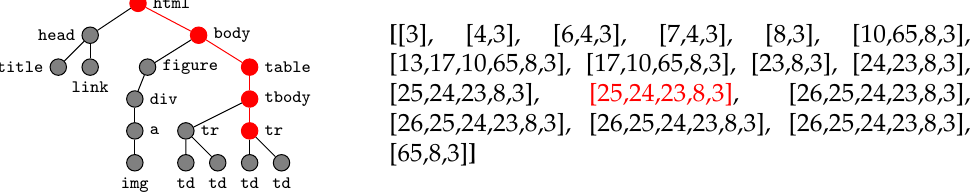
Figure 9. A DOM tree and the associated suffix array. The subpath consisting of red vertices and red edges in the left tree chart corresponds to the suffix displayed in red in the right suffix